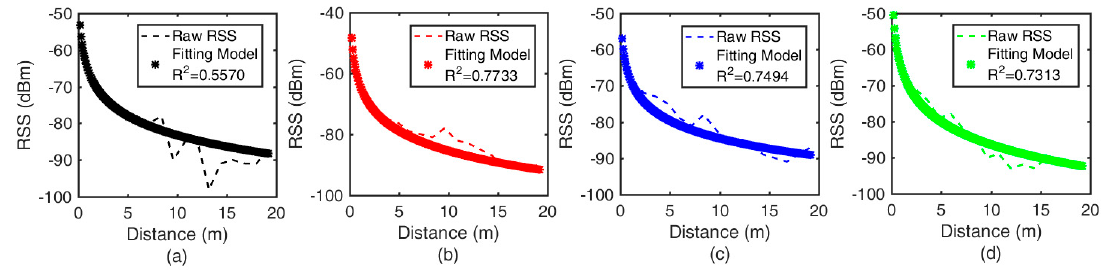
Figure 4. The signal-attenuation models for the Google Pixel 3 L: the fitting model for ( a ) CH all: R 2 = 0.5570; ( b ) CH 37: R 2 = 0.7733; ( c ) CH 38: R 2 = 0.7494; and ( d ) CH 39: R 2 = 0.7313.